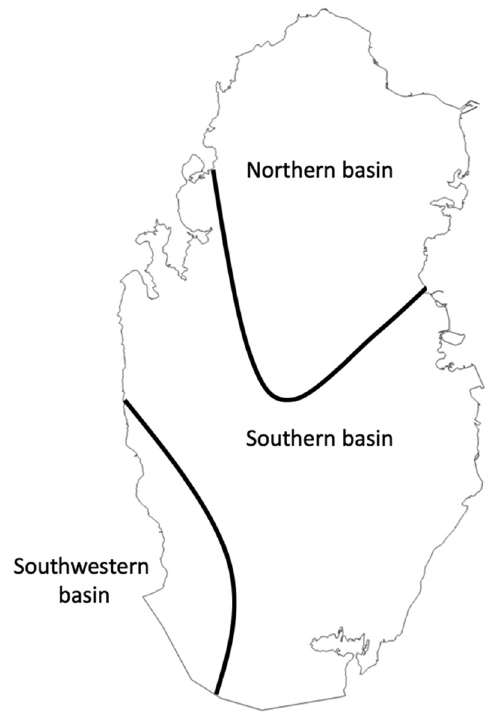
Figure 2. Hydrogeological map of Qatar (from Al-Hajari [5]).